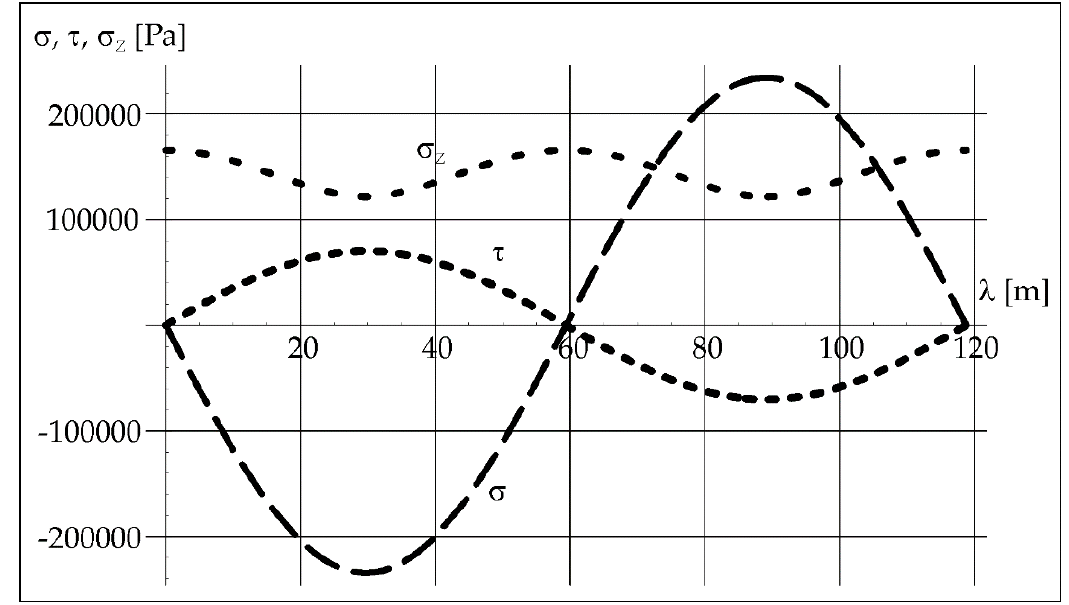
Figure 7. Stress distribution in steel at 50 Hz.